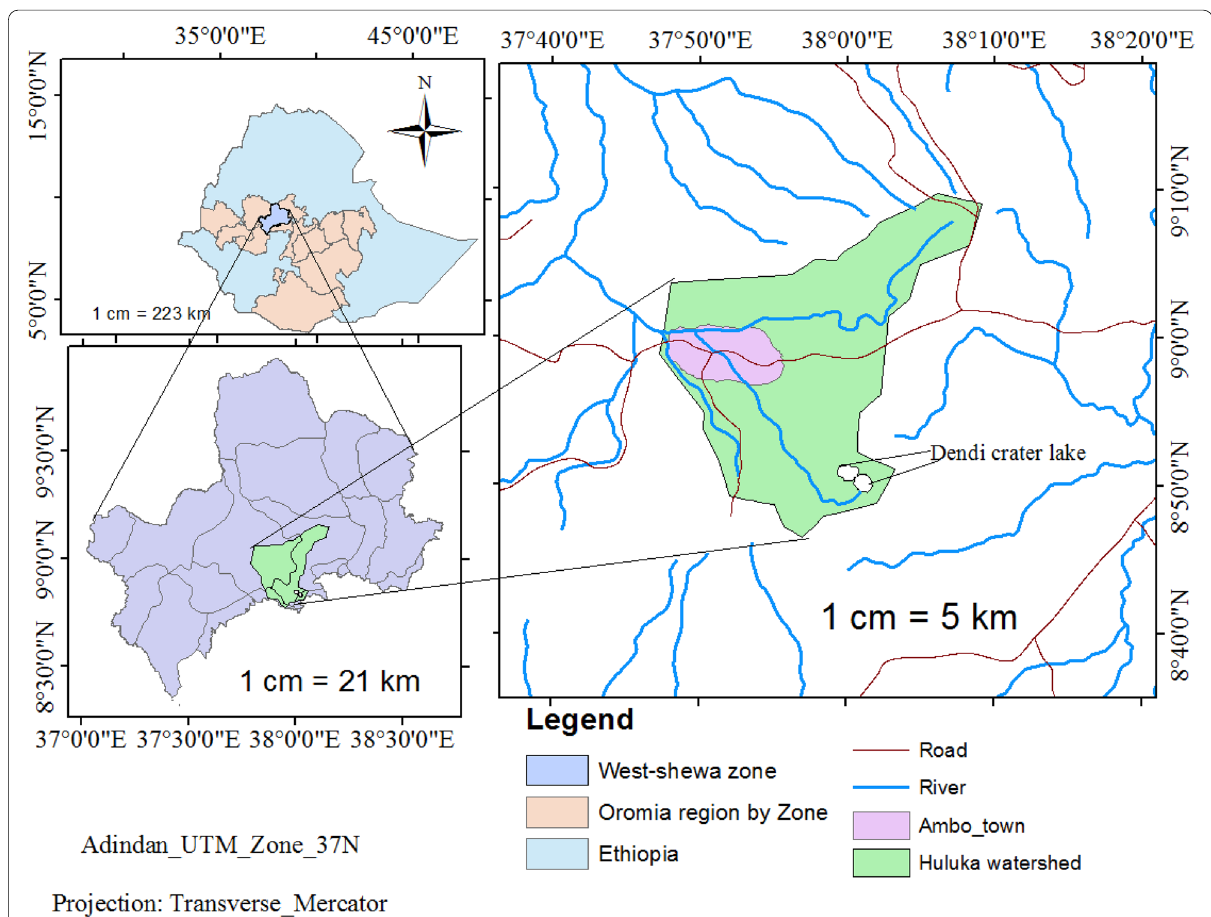
Fig. 1 Geographical location of Huluka